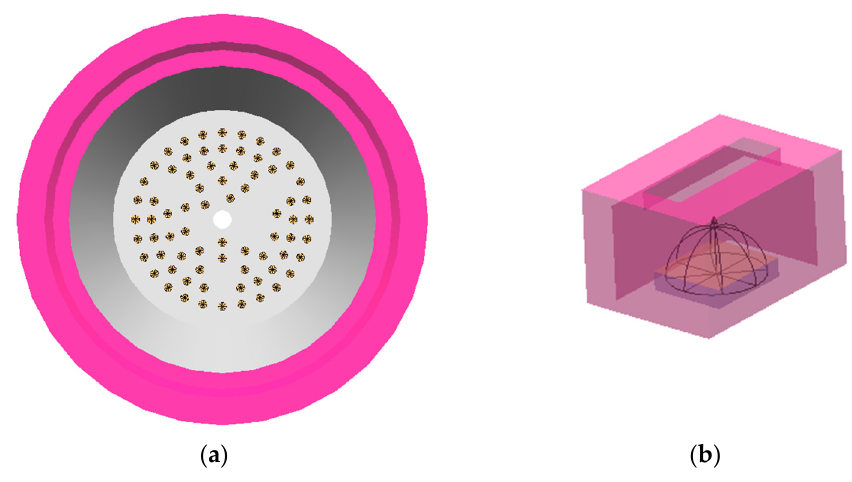
Figure 5. Simulation models of ( a ) the lighting fixture and ( b ) the red QD cap.